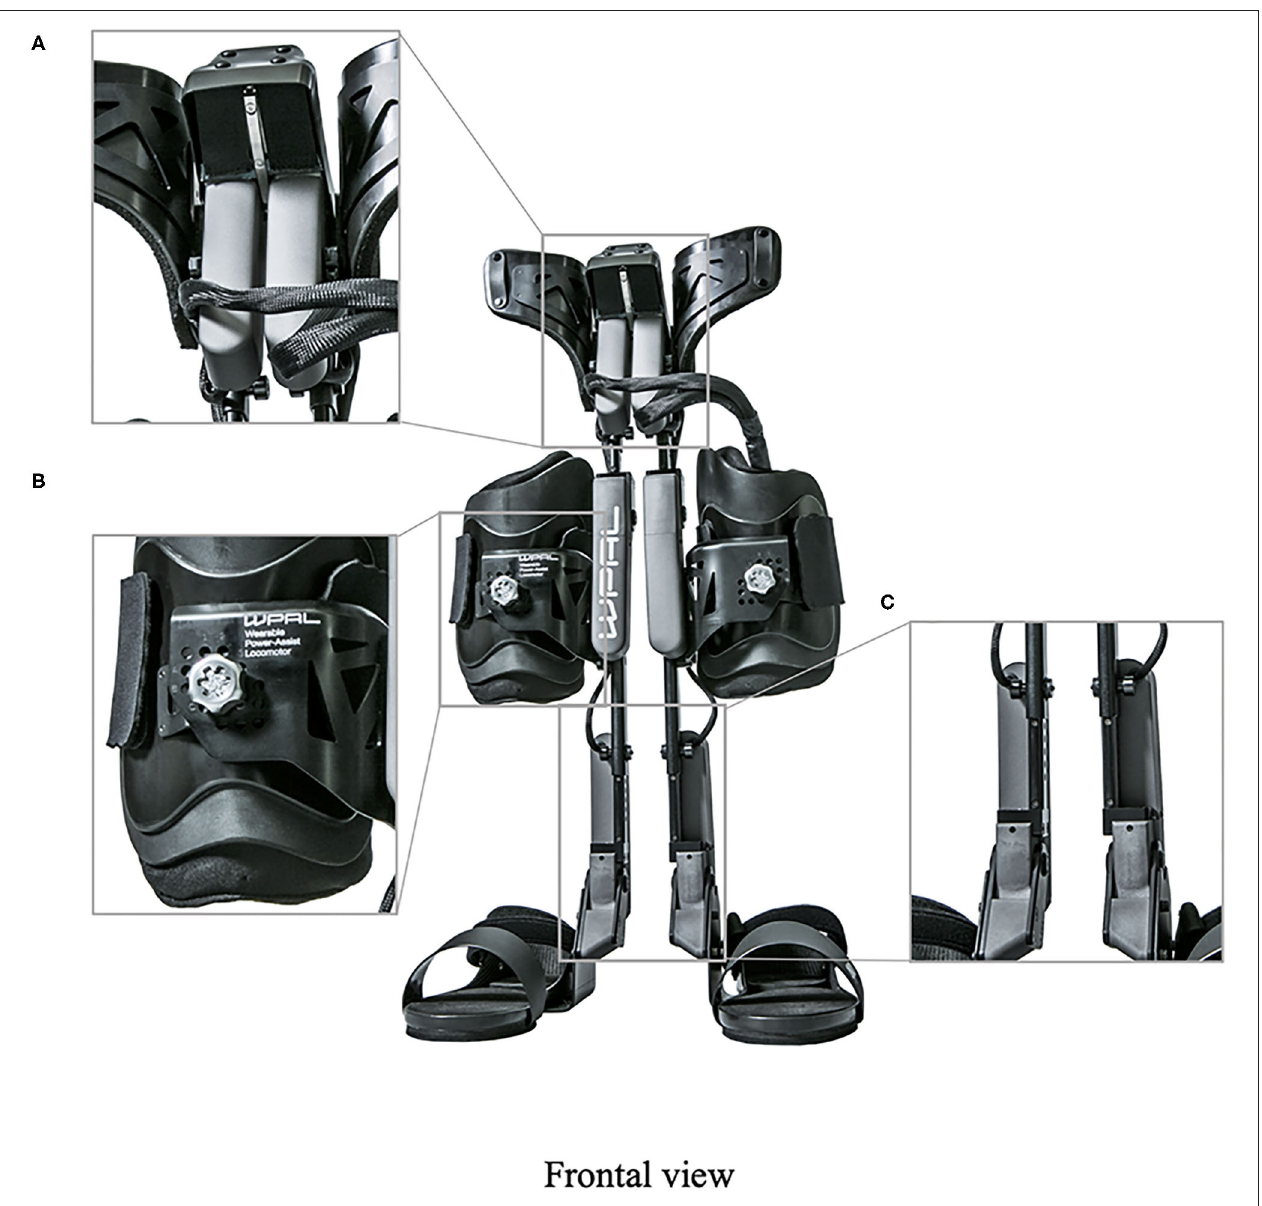
FIGURE 2 | The structure of the latest WPAL in detail. (A) The hip joint in frontal view, (B) the knee joint in frontal view, and (C) the ankle joint in frontal view. WPAL, Wearable Power-Assist Locomotor.